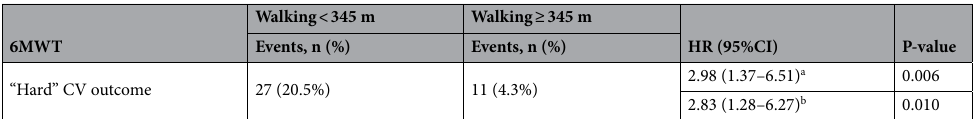
Table 3. Association of 6MWT with “hard” cardiovascular outcomes. 6MWT, 6-min walking test; CV, cardiovascular. “Hard” cardiovascular outcome is a composite of cardiovascular death or hospitalization for cardiovascular causes. a Model adjusted on age, waist circumference, NT-pro BNP, and anemia. b Model adjusted on age, waist circumference, NT-pro BNP, anemia, hypertension, diabetes, angina pectoris, heart failure history, and use of statins.